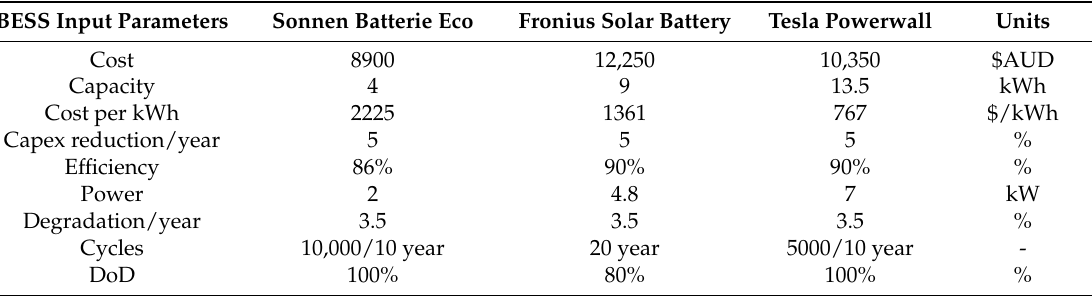
Table 4. BESS input